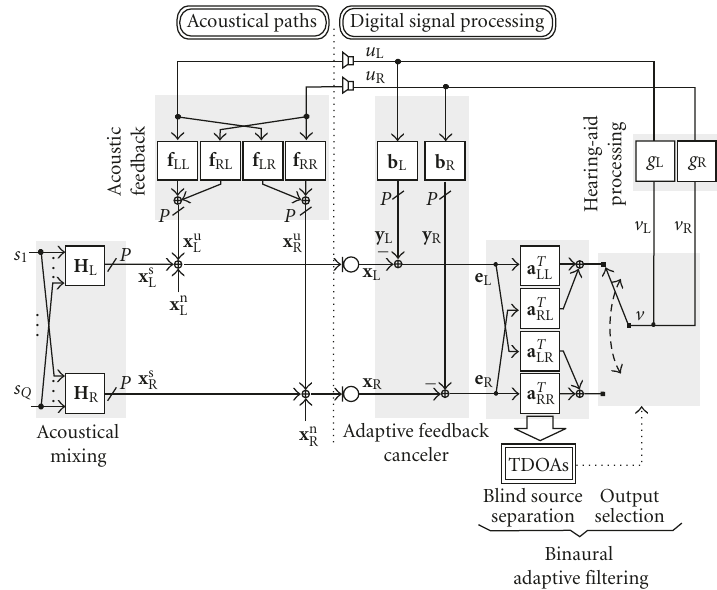
Figure 3: Signal model of the AFC-BSS